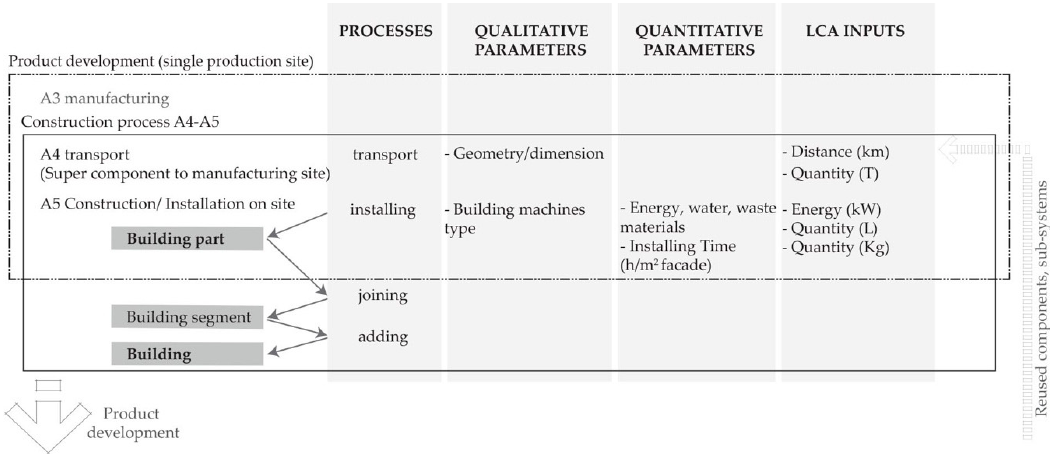
Figure 8. Mapping of LCA parameters in the phase A4–A5.